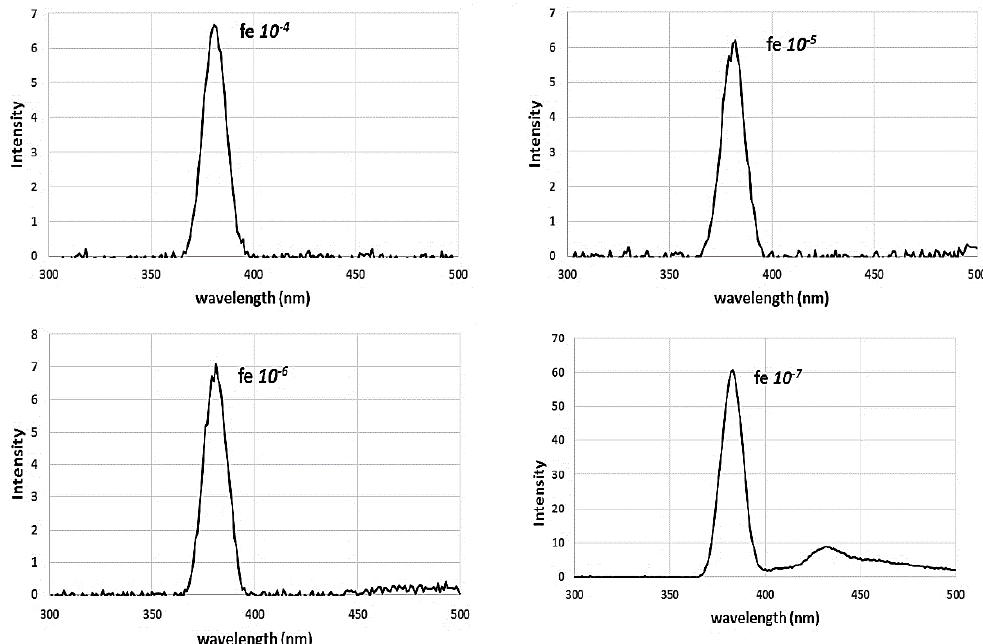
Fig.5: The fluorescence spectrum of Iron chloride with concentrations of (10 -4 , 10 -5 , 10 -6 , 10 -7 ) gm/m 3 .